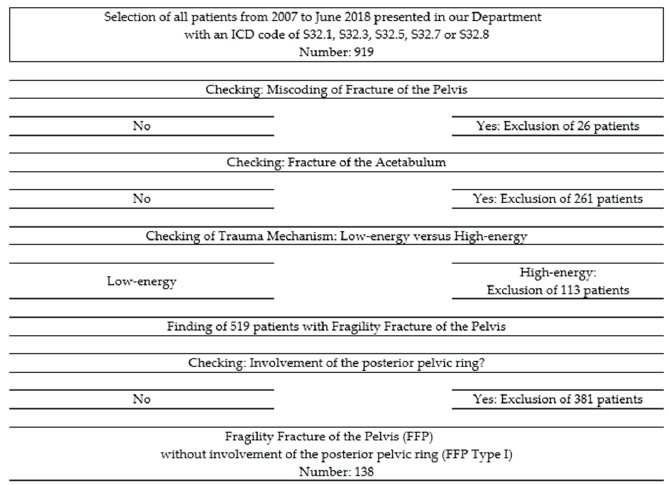
Figure 1. Flowchart of selected and excluded patients.